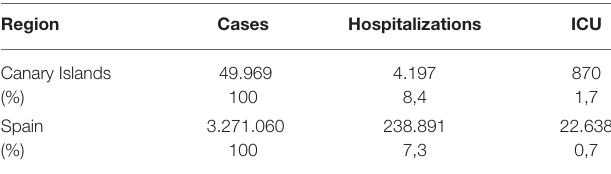
TABLE 2 | Number of positive cases, hospitalizations and ICU admissions in the Canary Islands and Spain (10 May, 2020–28 April,